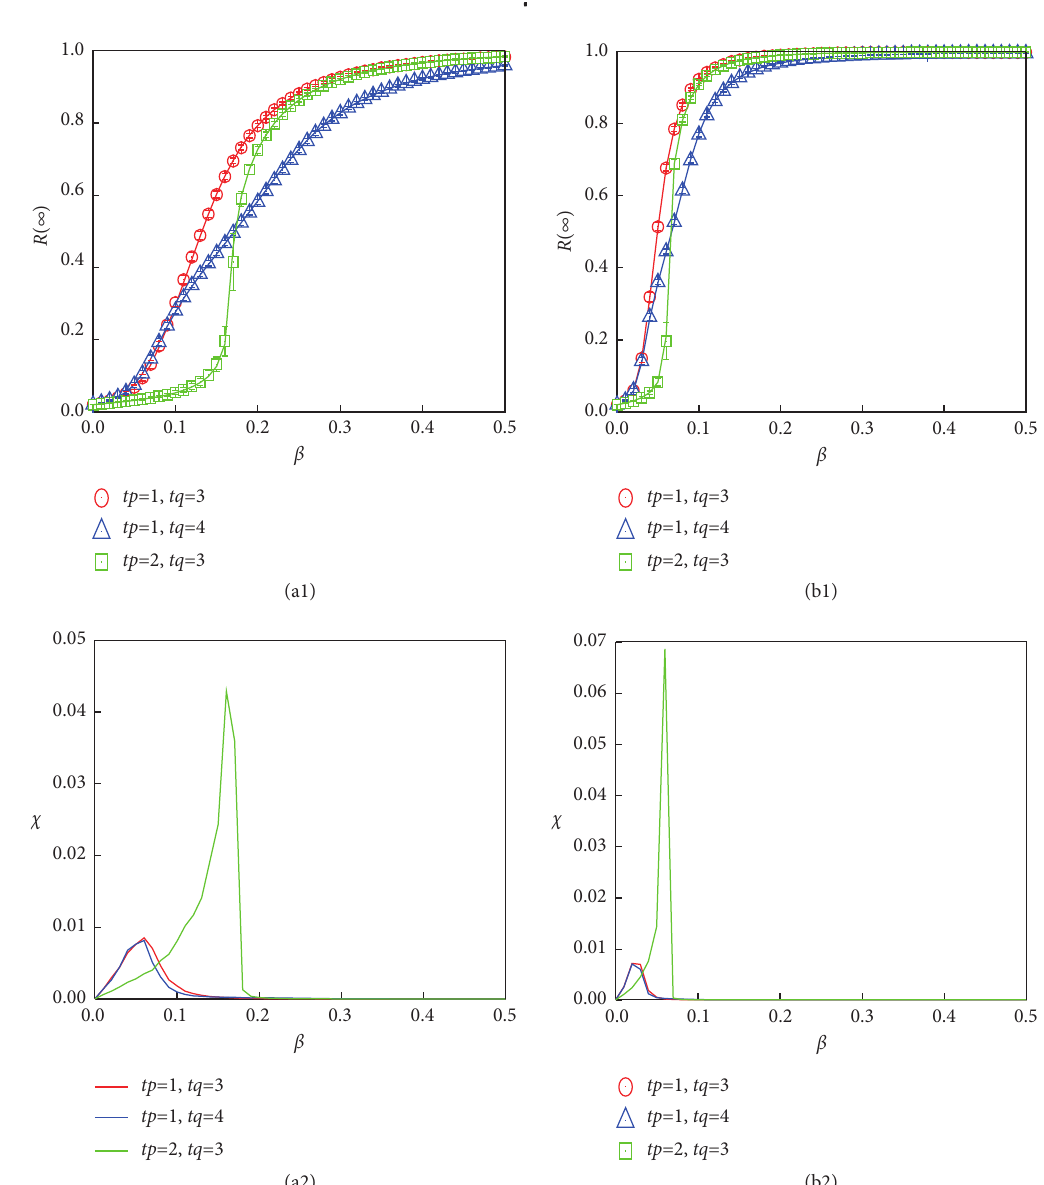
Figure 3: The effects of unit propagation probability β on the final adaption size with various adoption thresholds on weighted ER network. � 2 ) and (b1) ( α � 3 ) show the influence of weight distribution heterogeneity over phase transition. Subgraphs (a2) and (b2) (a1) ( α ω ω represent the relative variances of the theoretical analyses and the critical points of (a1) and (b1), respectively. The theoretically predicted values (dotted lines) coincide well with the simulation values (symbols). Other parameters are ρ